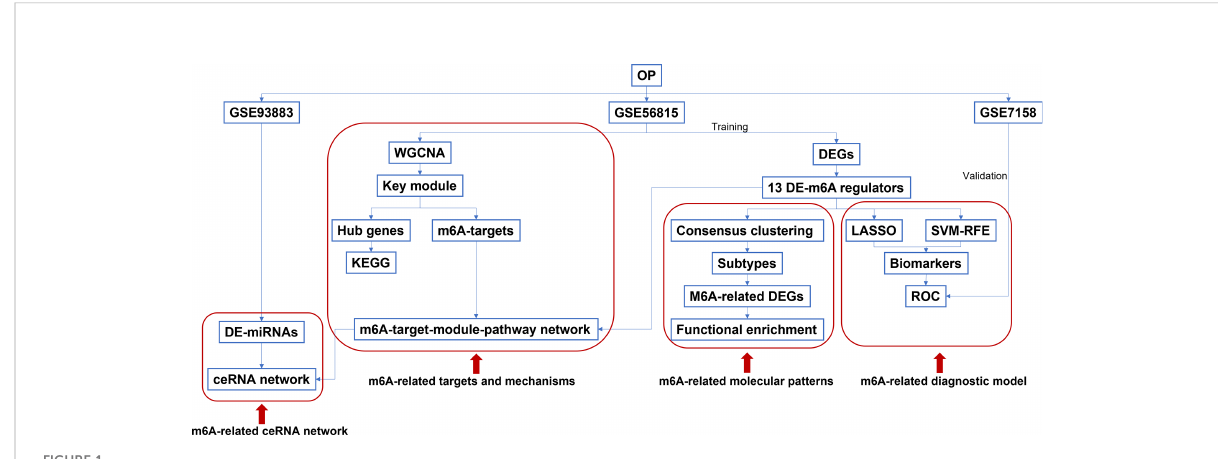
FIGURE 1 The work fl ow of the study